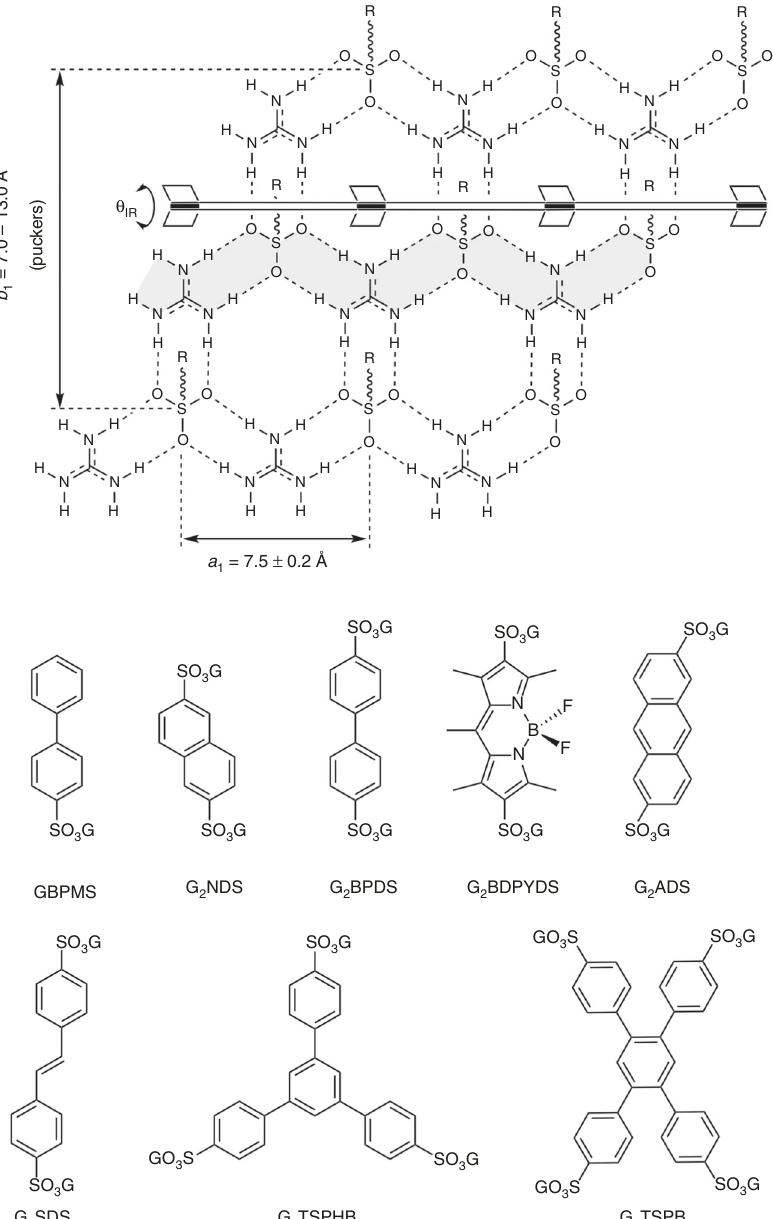
Fig. 1 GS framework components. Top: the typical quasi-hexagonal GS sheet, illustrating the hydrogen-bonded hinge between hydrogen-bonded major ribbons (one of these is highlighted in gray) that allows facile puckering of the GS sheet with concomitant shrink-wrapping around guests in the inclusion cavities. The R substituents on the sulfur atoms denote organic groups that can project from either side of the GS sheet. Bottom: Guanidinium organosulfonates used